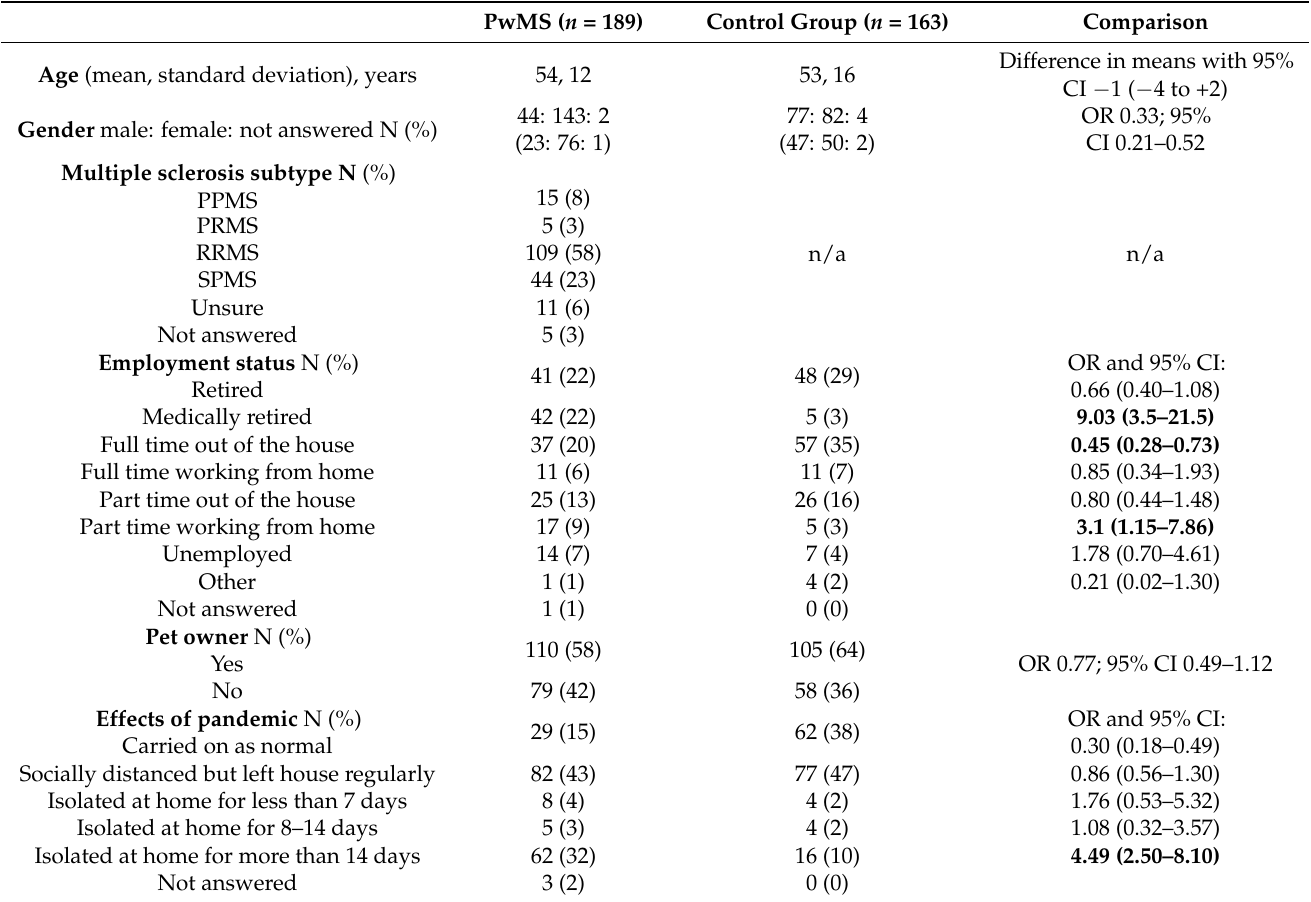
Table 2. Characteristics of participants. OR: odds ratio. CI: confidence interval